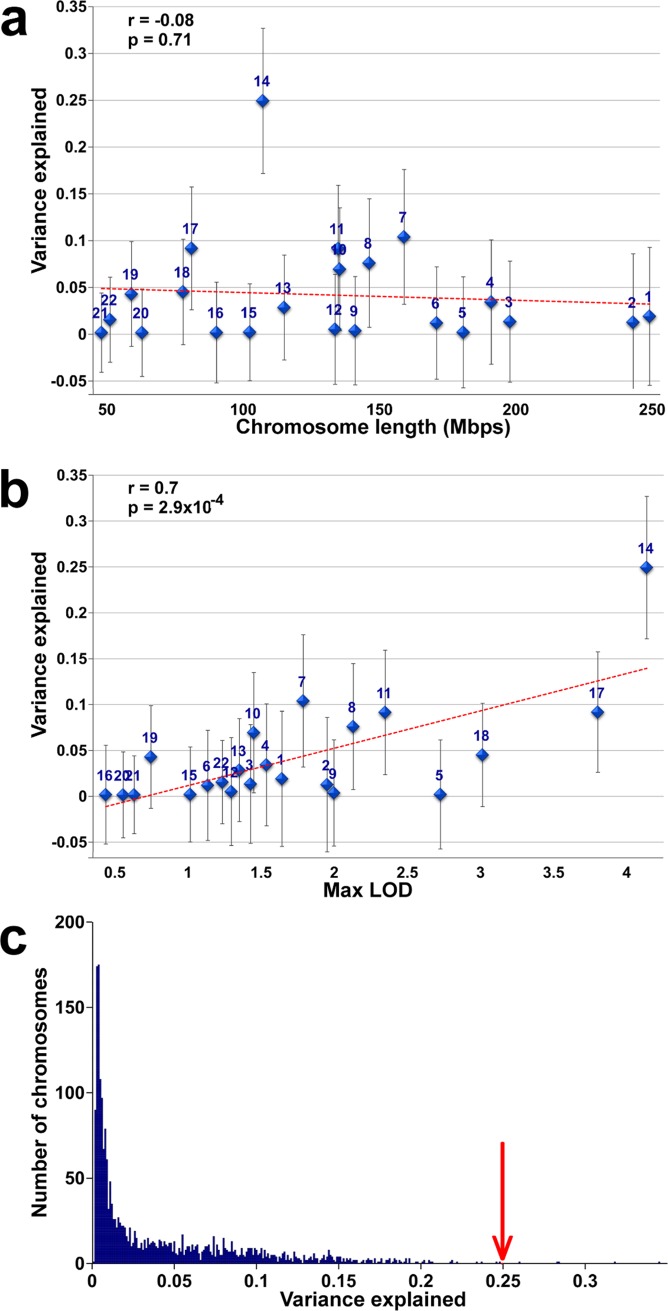
Height variance explained by chromosomes.(a) Height variance explained by each chromosome ± SE is plotted against chromosome length. Red line shows the linear fit. (b) Height variance explained by each chromosome ± SE is plotted against the maximum LOD score on that chromosome. (c) Histogram of variance explained by each of 2200 chromosomes simulated under an infinitesimal model. Red arrow shows variance explained by chromosome 14 in the real data.